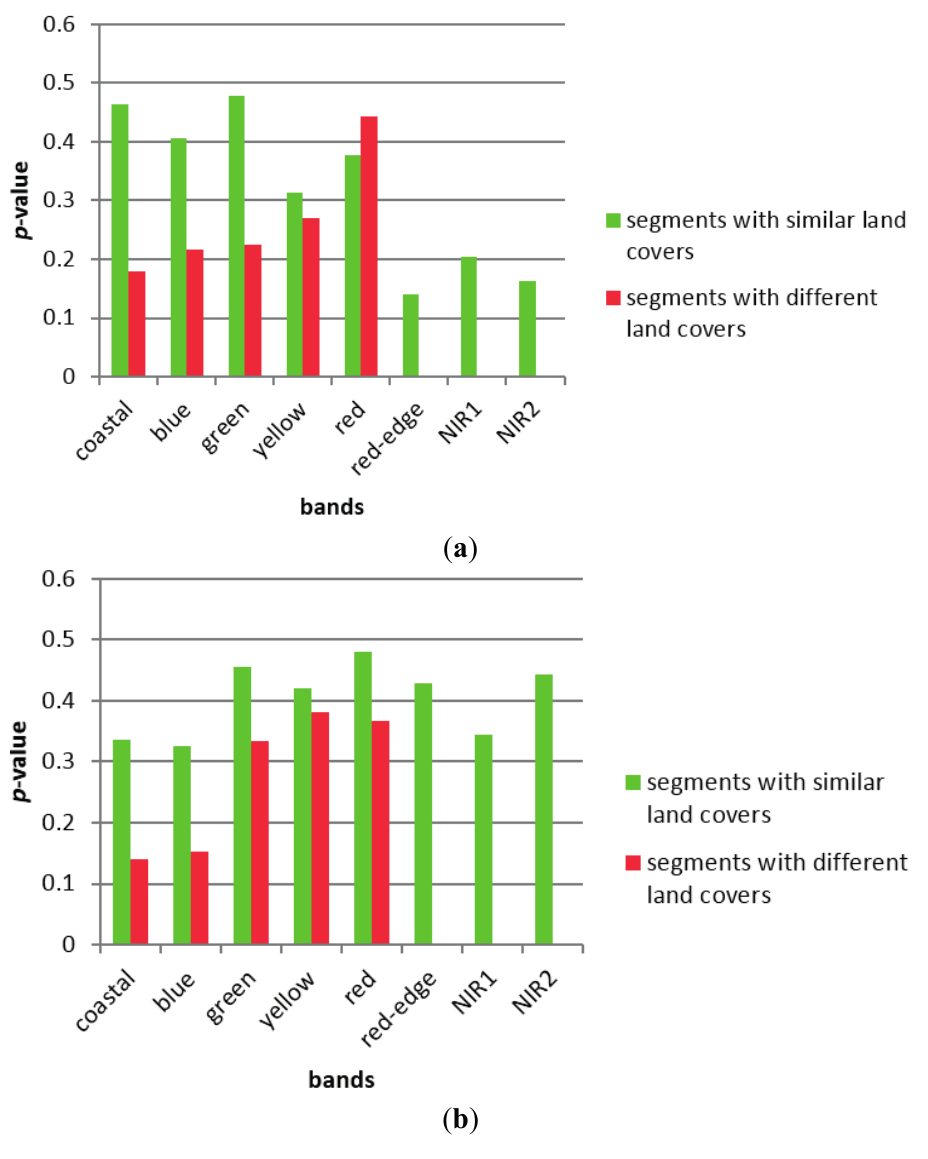
with the large segments. Figure 7. The difference in the p -value per individual band for 10 sampled pixels when: ( a ) the Kolmogorov-Smirnov statistics (Figures 5a and 6a combined); ( b ) the Student’s t -test statistics was applied (Figures 5b and 6b